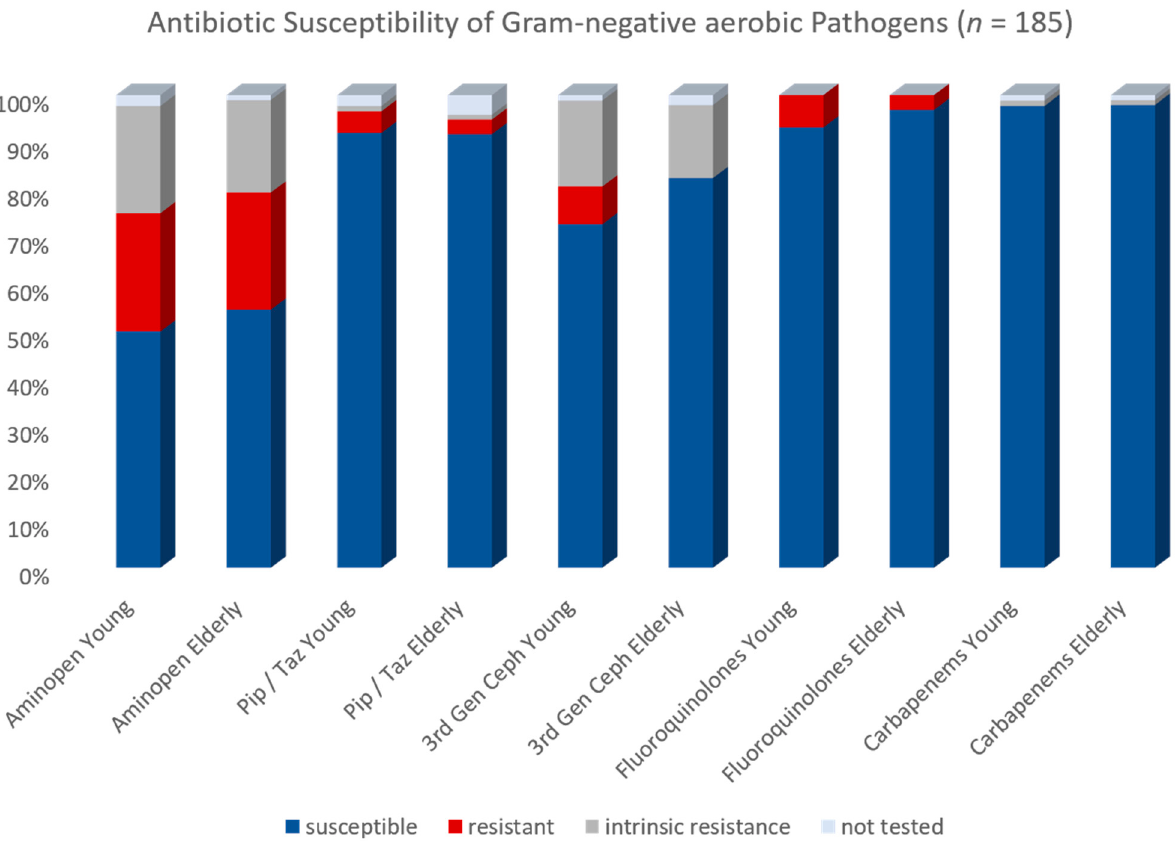
Figure 3. Antibiotic Susceptibility of Gram-negative aerobic Pathogens